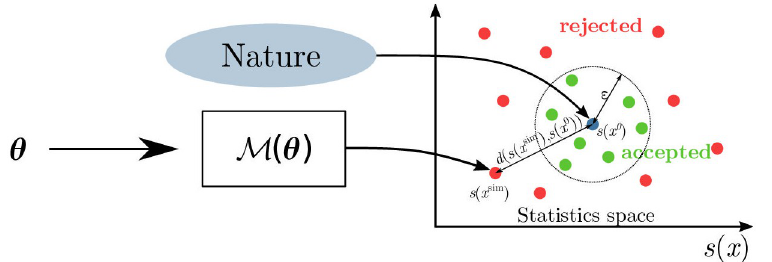
Fig 5. Approximate Bayesian computation. Having observed data x 0 from an individual patient (the gray dot), we sample parameter values θ from the prior and generate observations through the model simulator, M ð θ Þ , that are then accepted (green) or rejected (red) according to their distance from the observation measured by d ( x 1 , x 2 ) = || s ( x 1 ) − s ( x 2 ))|| 2 on the summary statistics